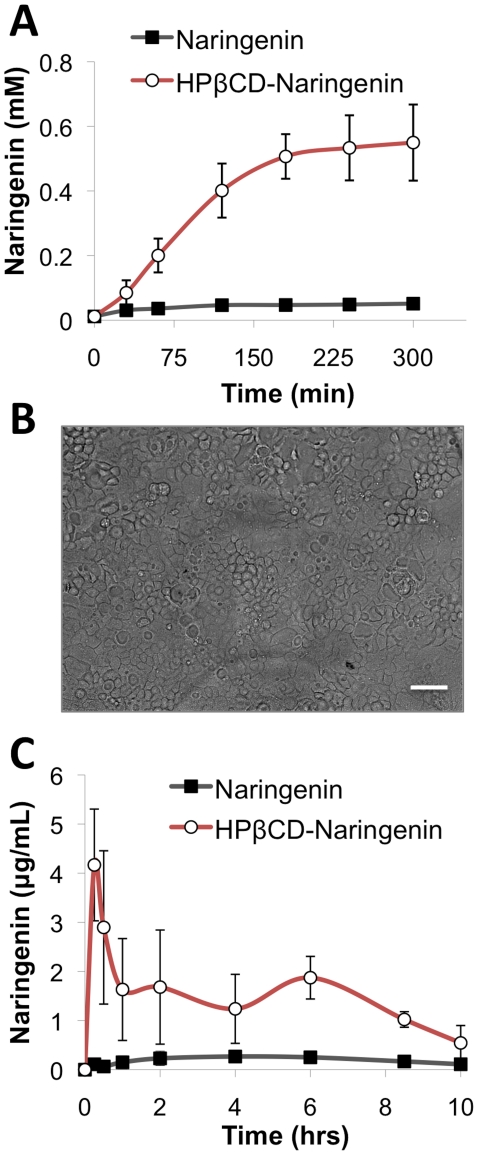
HPβCD enhances the bioavailability of naringenin.(a) 11 mM naringenin, either alone or in a complex with 45 mM HPβCD, was added to the top apical chamber of a Caco-2 model of human intestinal transport. In the presence of HPβCD, the concentration of naringenin was increased in the bottom basal side from 40±20 nM to 510±70 nM, representing an 11-fold enhancement of transport across the Caco-2 monolayer. (b) Phase image of Caco-2 monolayer grown for 21 days on collagen-coated transwell membranes. Barrier resistance remained unchanged during the course of the experiment. (c) Male Sprague-Dawley rats were fed 20 mg/kg body weight naringenin either alone, or as a HPβCD-naringenin complex. Blood samples were collected sequentially and analyzed for naringenin content by LC-MS. HPβCD-naringenin complex had higher oral bioavailability compared to naringenin alone. AUC0-10 of the HPβCD-naringenin complex increased by 7.4-fold (p = 0.005), and maximal concentration, Cmax increased by 14.6-fold (p = 0.002).